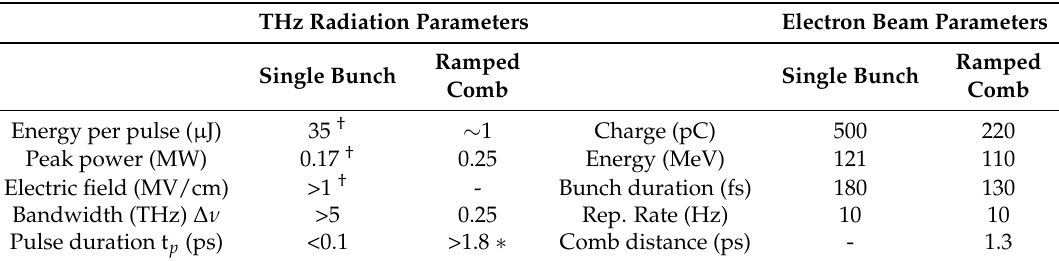
Table 2. SPARC_LAB THz sources: radiation and electron beam parameters for a single bunch and a ramped five-bunches